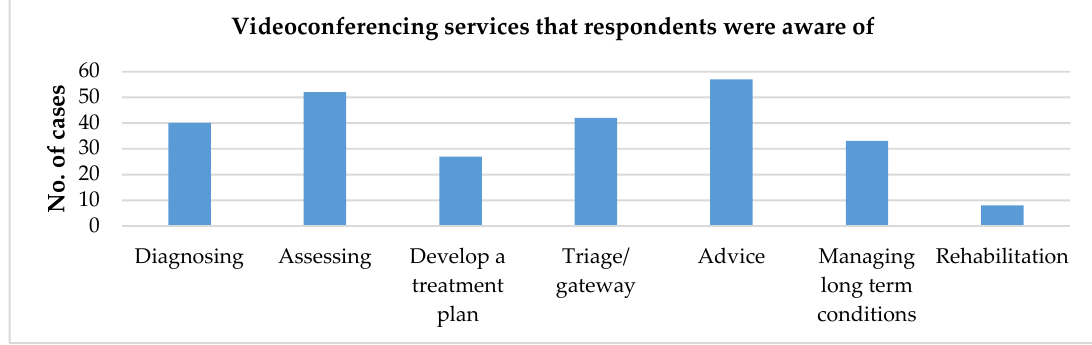
Figure 1. Breakdown of videoconferencing services that respondents were aware of.